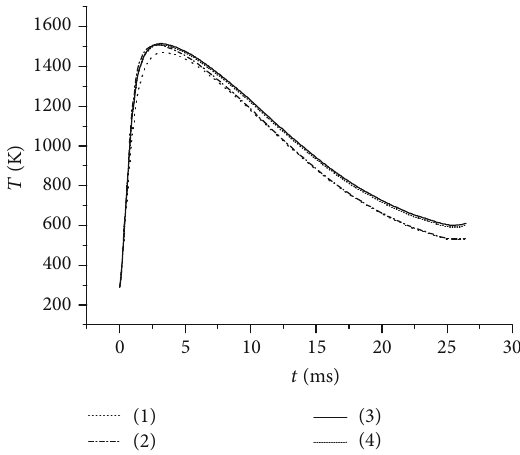
Figure 7: Chamber temperature results computed in di ff erent